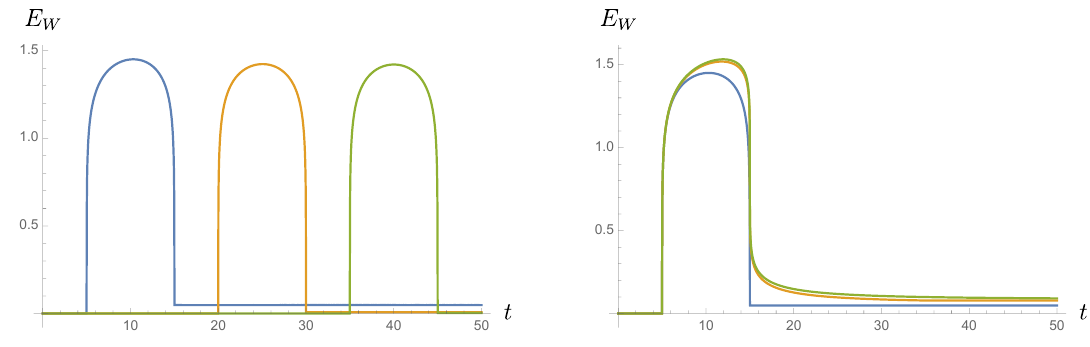
Figure 8 . Local joining quench: (cid:15) = 10 (cid:0) 3 , c = 1 (left) l 1 = l 2 = 10 ; d = f 10 ; 25 ; 40 g (right) l 1 = 10, l 2 = f 10 ; 30 ; 50 g , d =